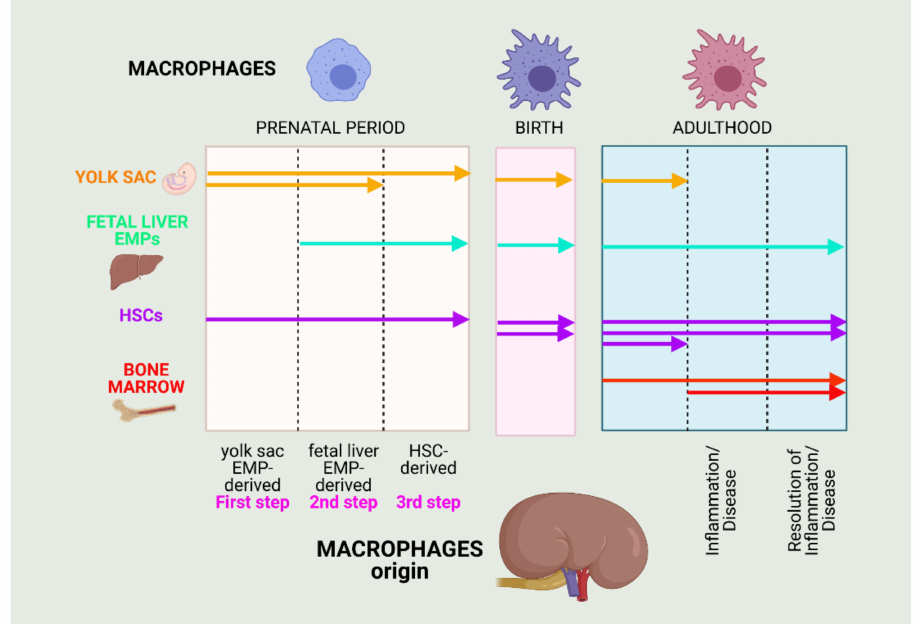
Figure 6. Macrophage origins in the kidney. MC sources in mice change throughout their develop- ment: in the prenatal period, at birth, and during adulthood. Thus, there are three sources in the embryo: yolk sac-derived erythro-myeloid progenitors (EMPs), fetal liver EMPs, and hematopoietic stem cells (HSCs). They constitute resident MC populations. Infiltrating MCs derive from bone marrow monocyte precursors and invade the kidney upon request, during an inflammatory process. Created with BioRender.com (accessed on: 7 March